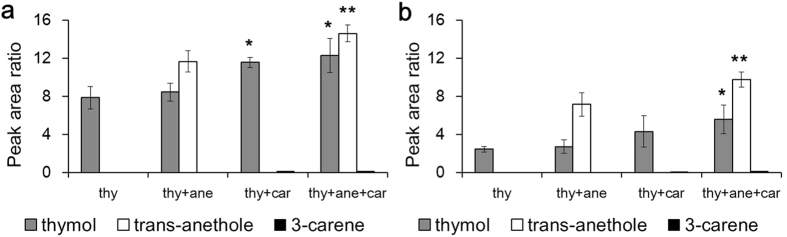
Penetration analyses of thymol and the mixtures with selected compounds in vivo in 1 h (a) and 2 h (b) post-treatment. In tertiary mixture, 3-carene significantly enhanced the penetration of thymol (*P = 0.01 (1 h) and 0.04 (2 h), respectively, compared to that of thymol alone) and trans-anethole (**P = 0.02 (1 h) and 0.04 (2 h), respectively, compared to the thymol + trans-anethole mixture).